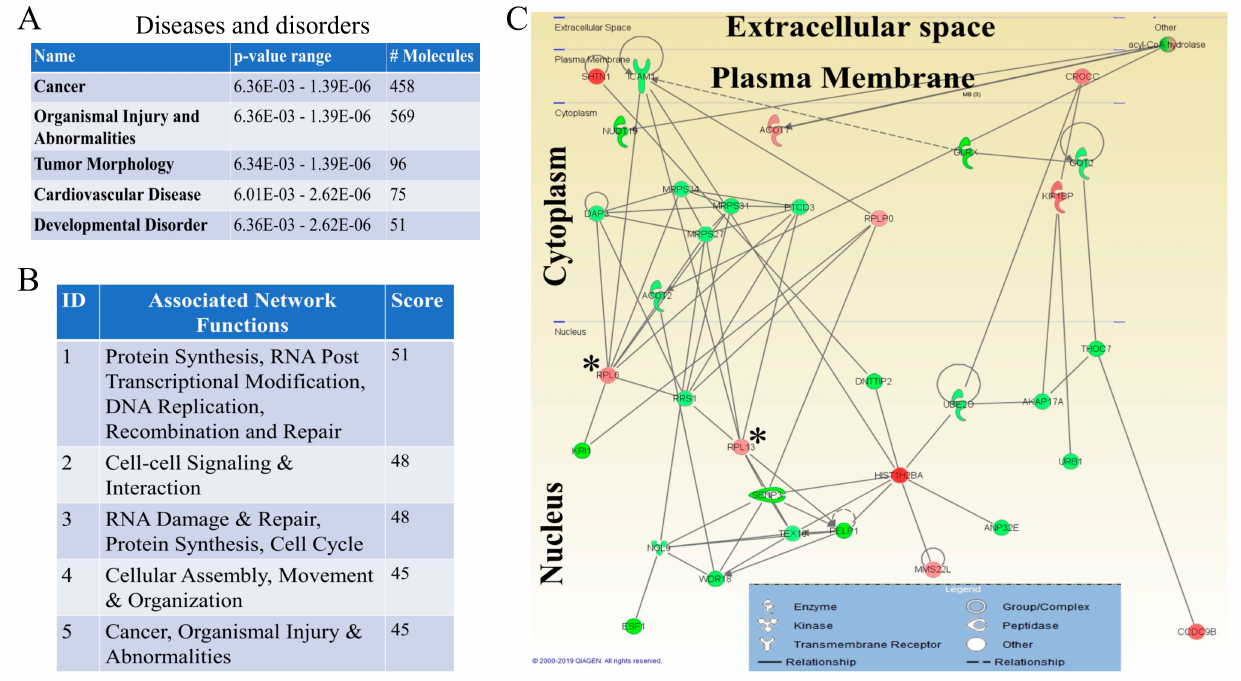
Figure 5. Diseases-associated pathways and protein network in the mdig KO vs. WT MDA-MB-231 cells as analyzed by IPA. ( A ), Top Diseases and Disorders, depicts the affected functional categories based on differentially expressed proteins where the Name column displays a category of diseases and functions showing Cancer, Organismal Injury and Abnormalities, Tumor Morphology, Cardiovascular Disease and Developmental Disorder as the top diseases in the proteomics dataset, along with the number of molecules associated with the individual diseases and disorder. ( B ), IPA of protein networks in the MDA-MB-231 KO over WT cells. The top five significant networks as determined by the IPA with their scores and associated functions has been shown. ( C ), Protein network showing the relationships and connectivity between the focus molecules of the network related to protein synthesis, RNA post transcriptional modification, DNA replication, Recombination and Repair. Red indicated increased and green indicates decreased expression. Star * represents the elevated ribosomal proteins in this